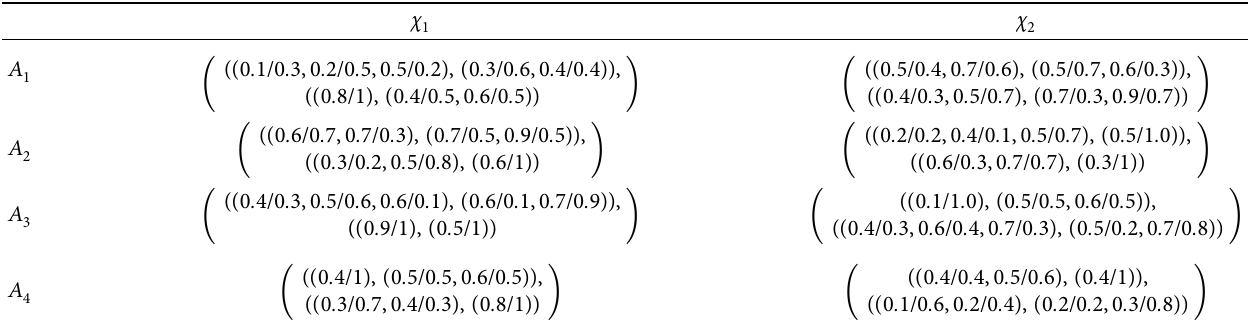
Table 7: Expert information.